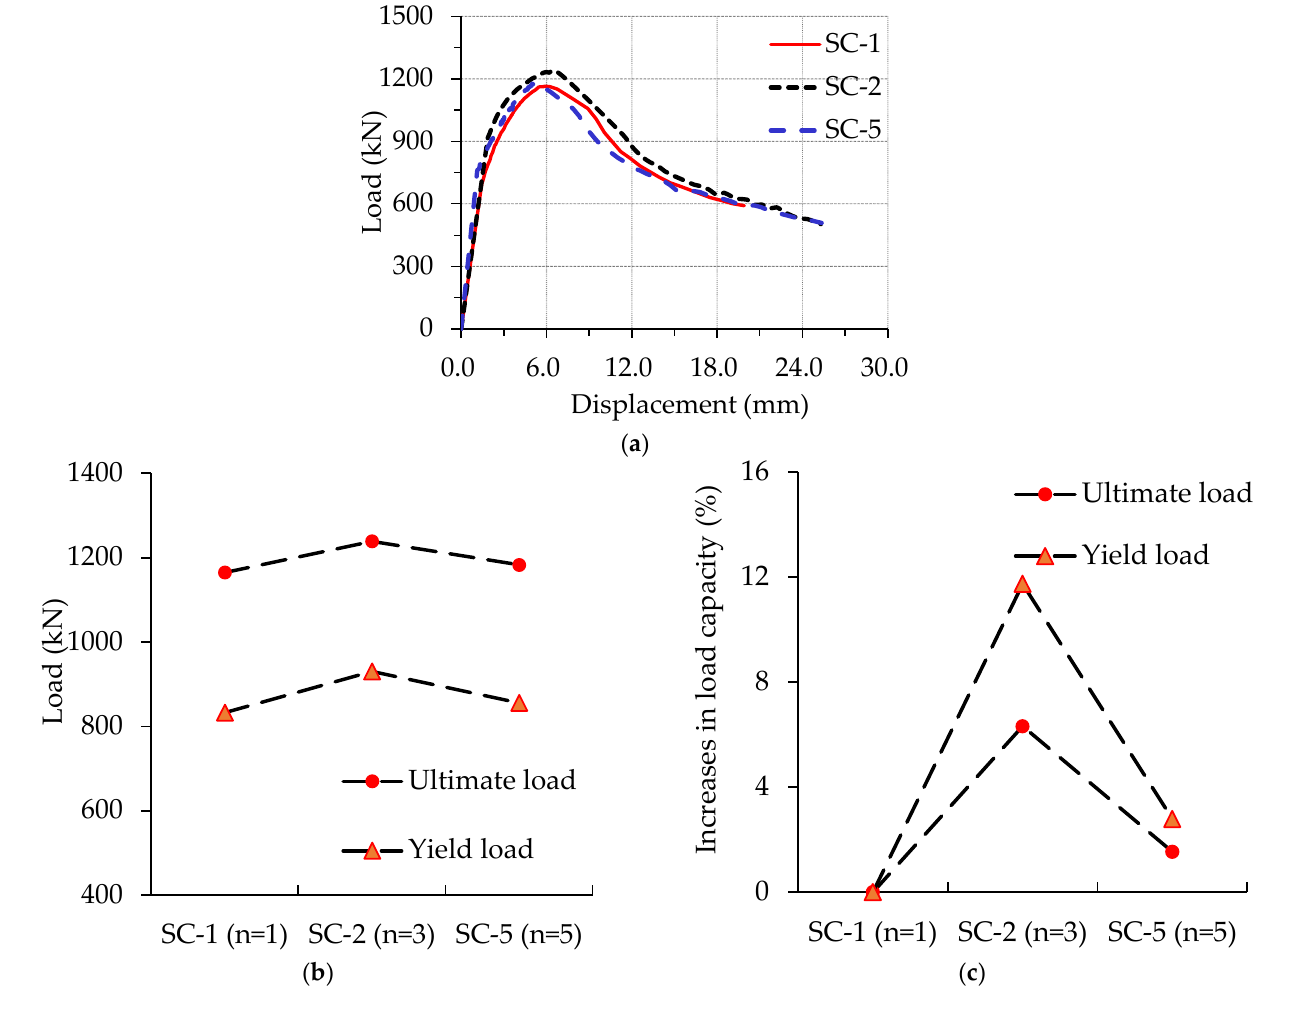
Figure 11. Comparisons of specimens with different bolt number: ( a ) comparisons of load-displacement curves with various bolt numbers; ( b ) yield load and ultimate load with various bolt numbers; and ( c ) percentage variation of load capacity with various bolt numbers.